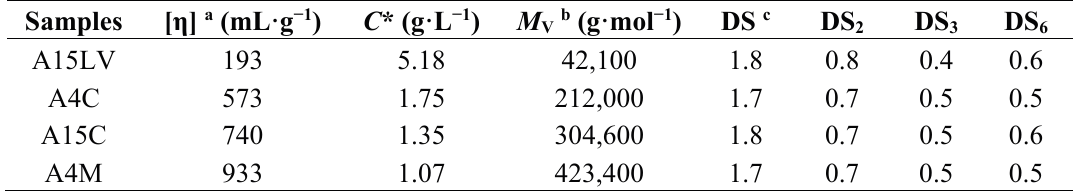
Table 2. Commercial methylcellulose characteristics. Reproduced with permission from Taylor & Francis Group, 2015